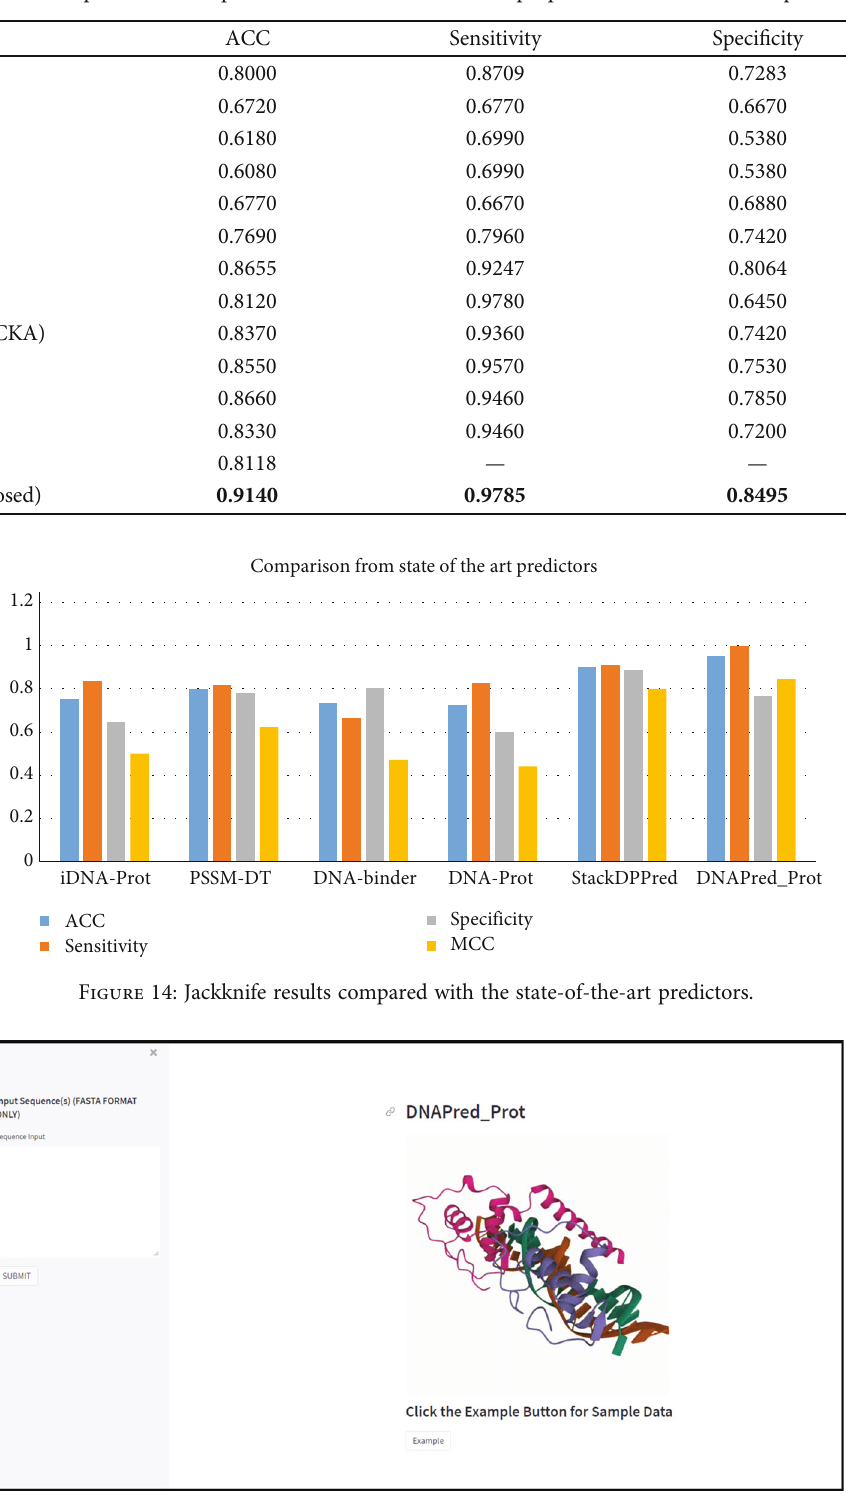
Figure 15: Visualization of the web